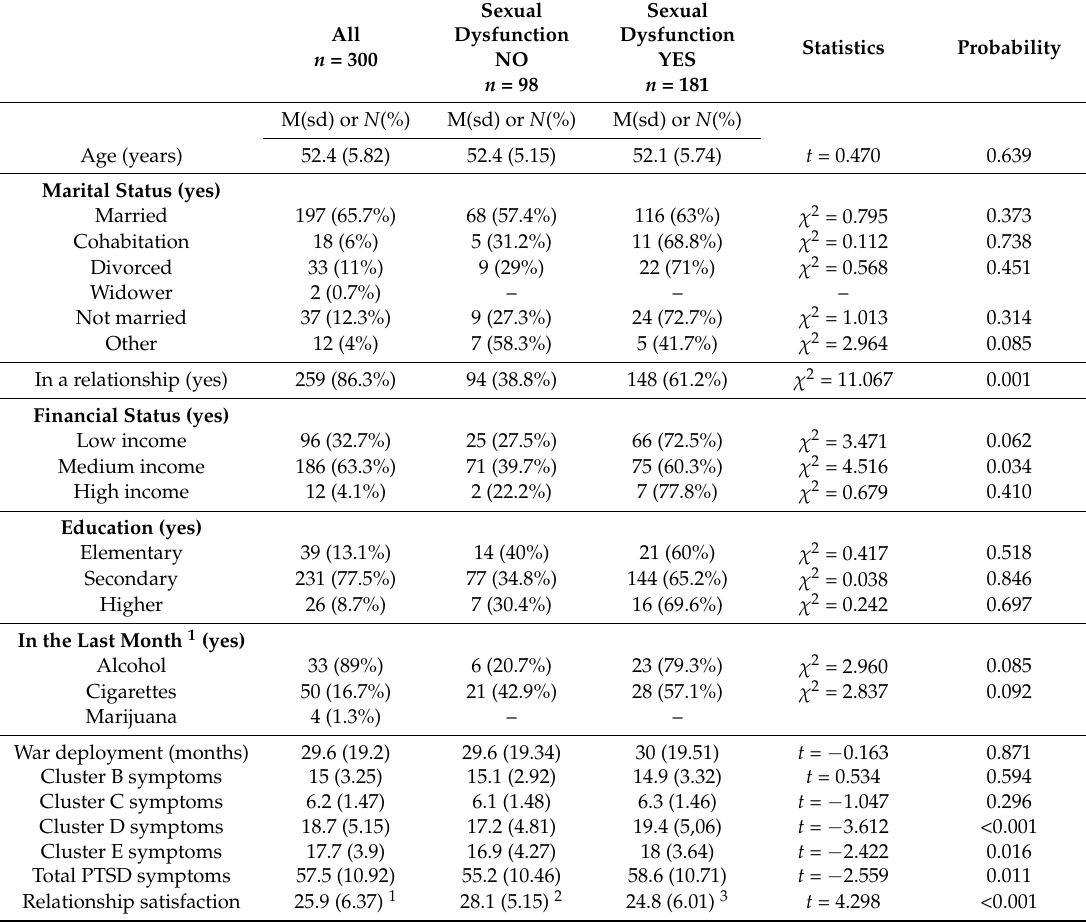
Table 1. Sociodemographic characteristic and differences according to the presence of sexual